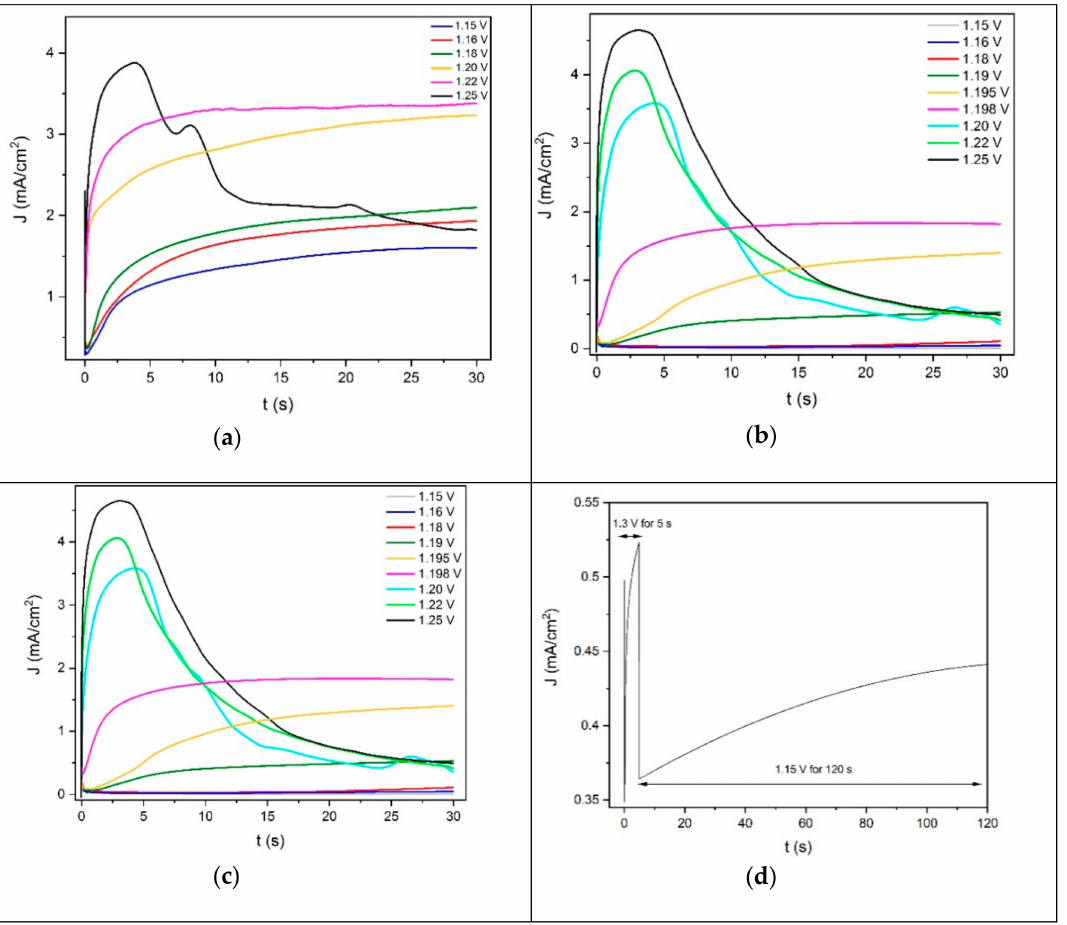
Figure 2. Chronoamperograms of EDOT solution at various potentials for 30 s on ( a ) gold, ( b ) palladium and ( c , d )